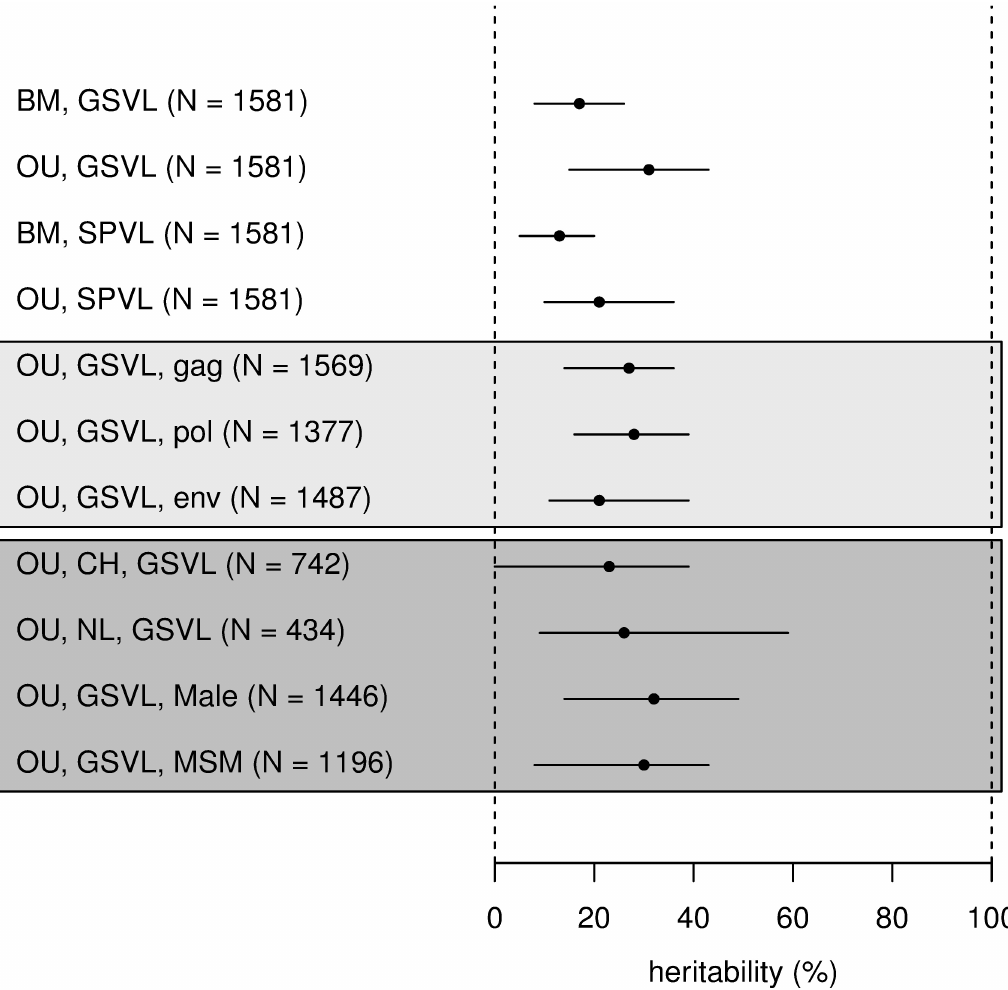
Fig 2. Maximum likelihood estimatesof heritability (points) and bootstrap confidence intervals (segments) for subtype B sequence. This is shown for the BM and OU model and the GSVL and SPVL measuresof viral load for the whole-genome phylogeny; for the OU model and GSVL on the phylogeny inferred only from gag , pol , and env genes (light grey box); and for several stratifications of the data, only when the size of the subset was greater than 400 (dark grey box). CH: Switzerland, NL: the Netherlands; male sex; MSM. The data used in the figure are providedas S1